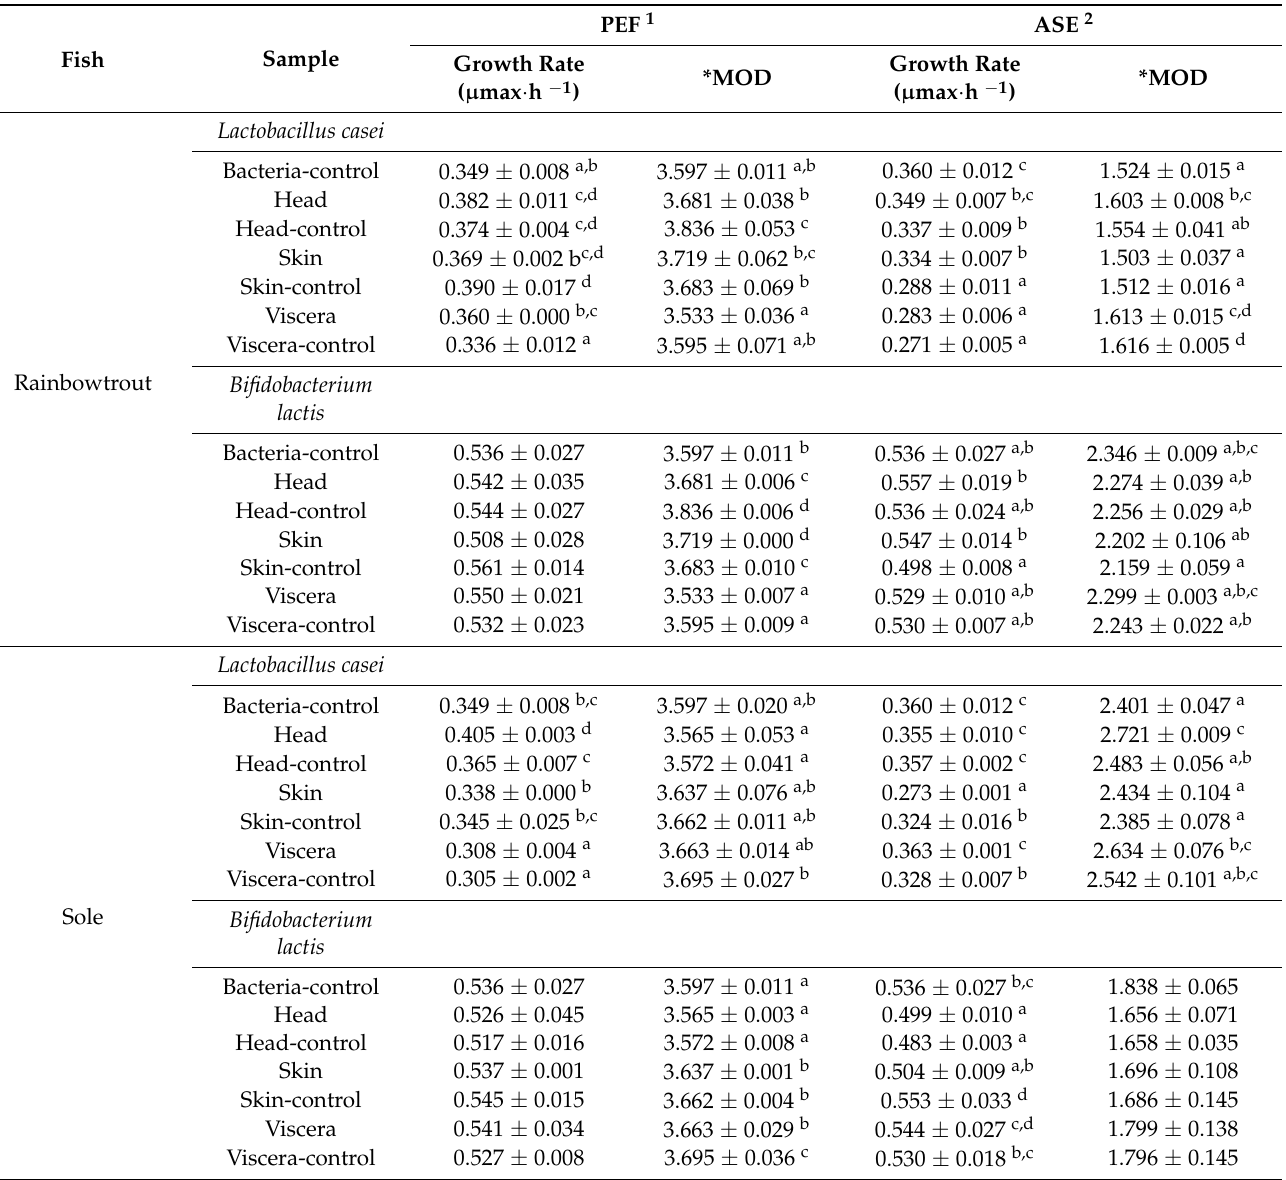
Table 5. Effect of the rainbow trout and sole extracts on the growth rate and maximal optical density of two probiotic bacteria